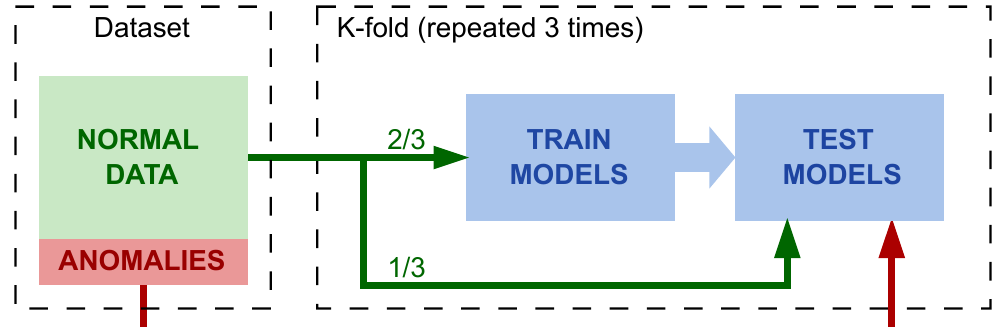
Figure 4. Experimental setup